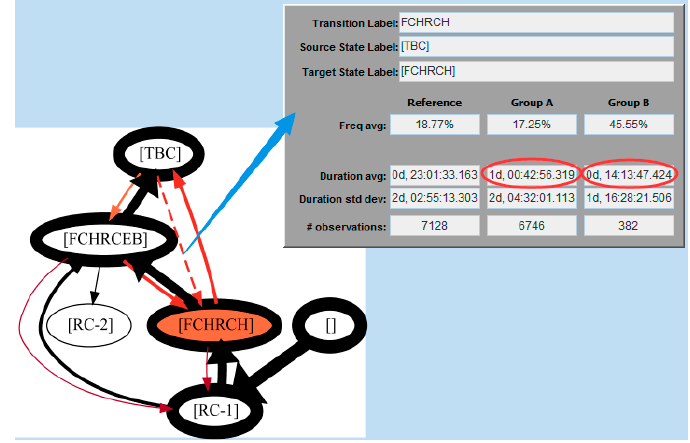
Figure 10. Process comparison of CHS cases with different complaint grades.